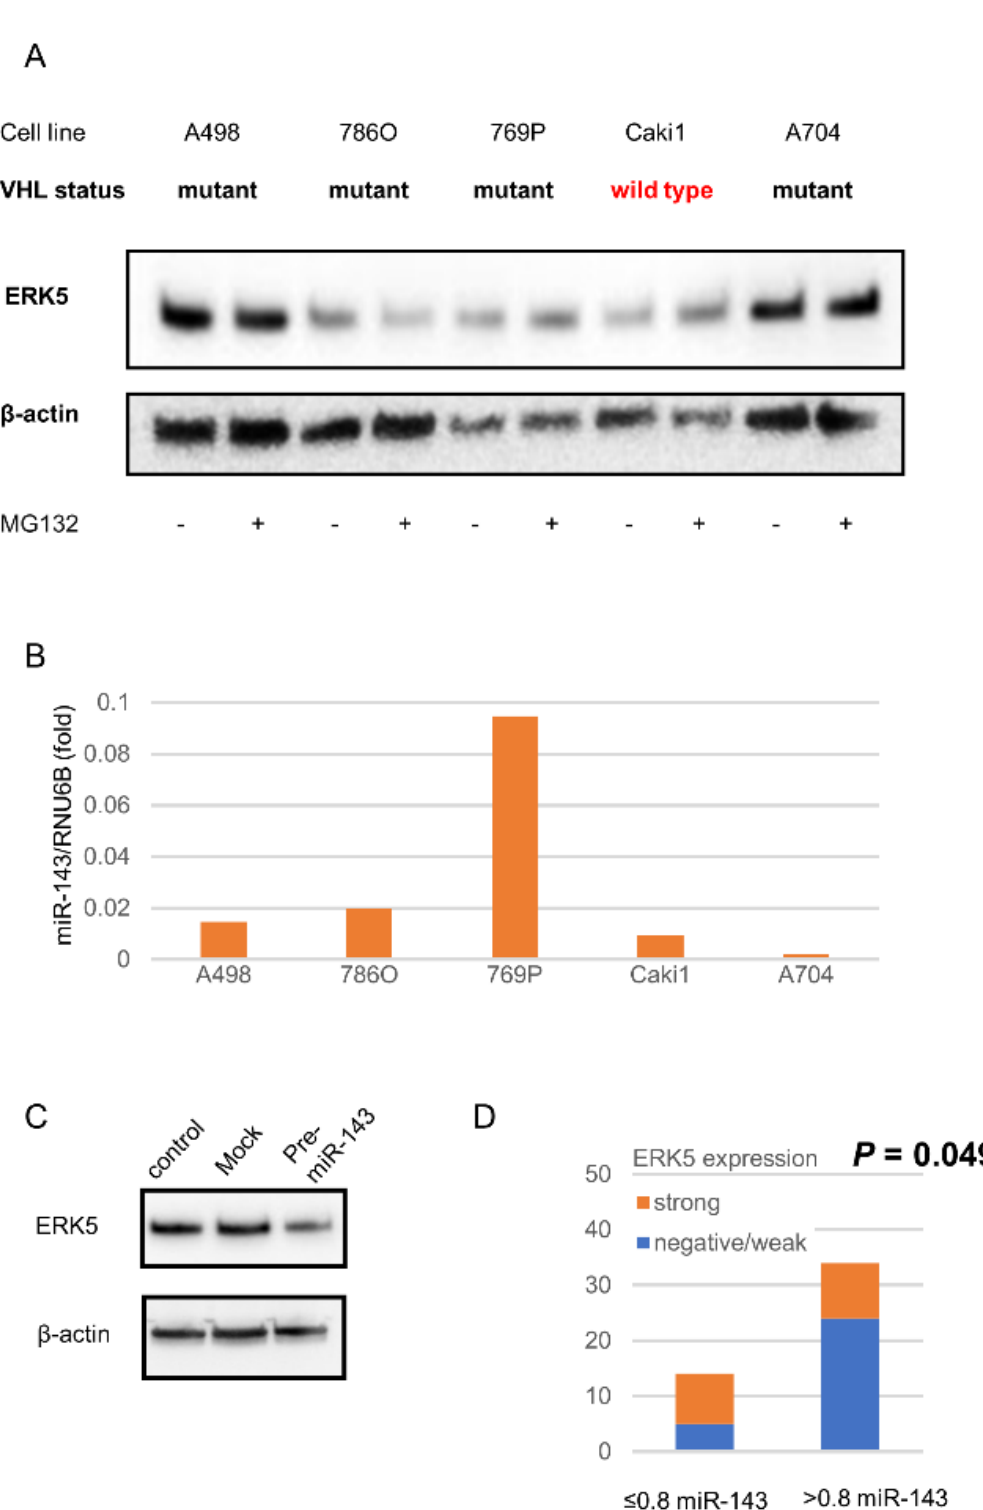
Figure 2. Correlations between ERK5 and miR-143. ( A ) ERK5 expression with/without proteasome inhibitor MG132 in RCC cells. The RCC cells were treated with 20 μ M MG132 for 24 h. ( B ) miR-143 expression level in RCC cells. ( C ) Transduction of pre-miR-143 suppressed ERK5 expression. ( D ) miR-143 expression in surgical specimens. ( E ) Specimens with decreased miR143. Abbreviation; ERK5, extracellular signal-regulated protein kinase 5; RCC, clear cell renal cell carcinoma.